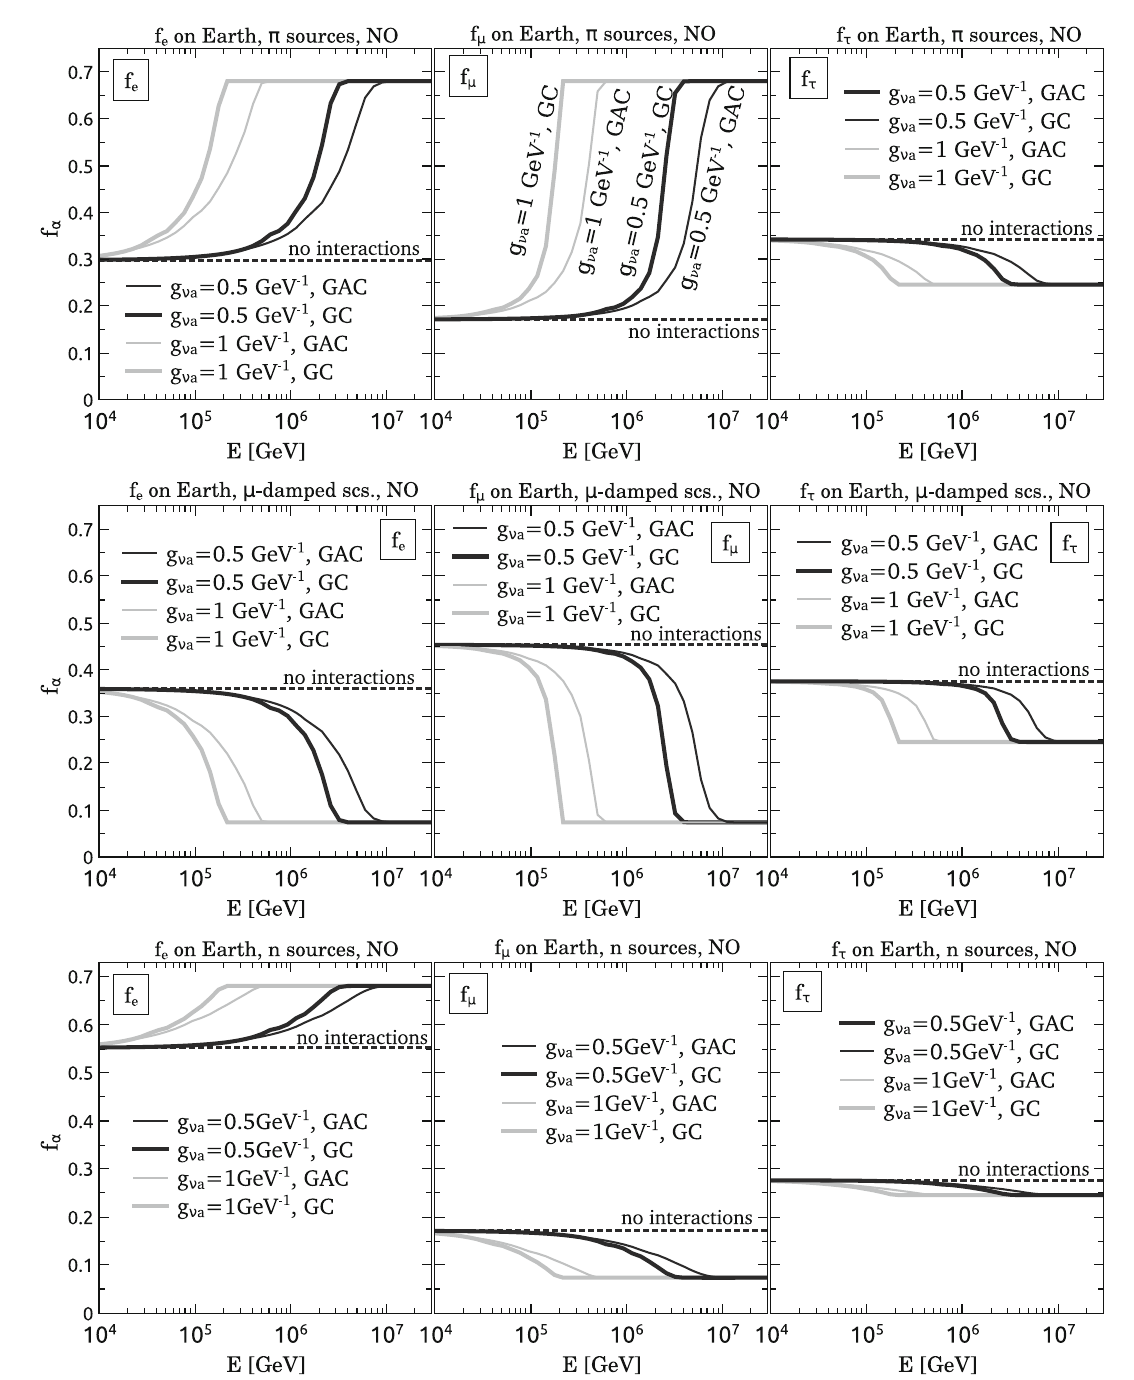
Fig. 7 Energy dependent flavor ratios of neutrinos reaching the Earth in the NO case for the electron, muon, and tau flavors in the left, center, and right panels, respectively. Thick solid lines correspond to the half of the sky centered around the galactic center (GC), while thin lines cor-